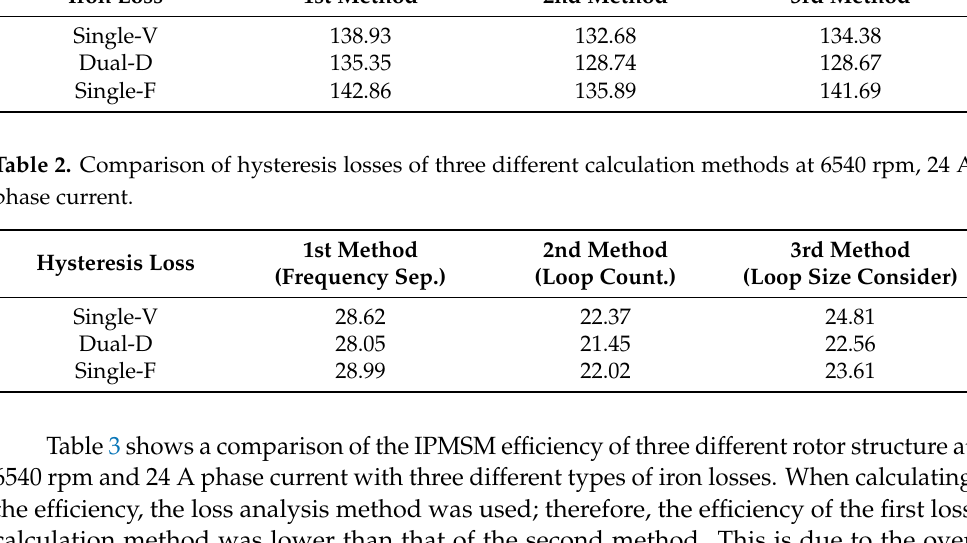
Table 3. Efficiency comparison of three different rotor structure at 6540 rpm, 24 A phase current based on three different type of iron Table 2. Comparison of hysteresis losses of three different calculation methods at 6540 rpm, 24 A phase current.